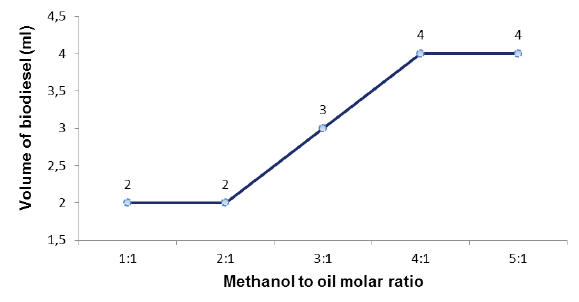
Figure 3: The effect of different methanol to oil ratios on the transesterification of used cooking oil. Conditions: reaction time of 2 hours, reaction temperature of 65°C, catalyst weight of